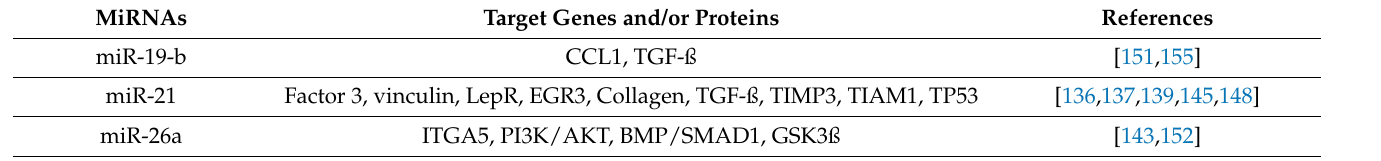
Table 7. This table summarizes the various miRNAs and their genes and/or proteins target, as studied in the papers included in this review, if available. CCL, chemokine ligand; TGF, transforming growth factor; LepR, leptin receptor; EGR, early growth response; TIMP, metallopeptidase inhibitor; TIAM1, T-cell lymphoma invasion and metastasis inducing protein 1; TP, tumor protein; ITGA, inte- grin subunit alpha; PI3K, phosphoinositide 3 kinase; AKT, protein kinase B; mTOR, mammalian target of rapamycin; BMP, bone morphogenetic protein; SMAD, small mother against decapentaplegic; GSK, glycogen synthase kinase; IGR1R, insulin-like growth factor 1 receptor; IL, interleukin, PTPRC, protein tyrosine phosphatase receptor type C; CD, differentiation cluster; SHIP2, SH2-containing phosphatidylinositol 3,4,5-trisphosphate 5-phosphatase; RNU6B, RNA U6 small nuclear; MAPK, mitogen-activated protein kinase; NF-kB, nuclear factor kappa-light-chain-enhancer of activated b cells; TCF-4, transcription factor 4; ID-2, inhibitor DNA-binding 2 protein HLH; VEGFA, vascular en- dothelial growth factor A; NRCAM, neuronal cell adhesion molecule; C-MET, tyrosine-protein kinase Met; LASP1, LIM and SH3 protein 1; RAN, RAs-related nuclear protein; RAPH1, Ras-associated and pleckstrin homology domains-containing protein 1; ERM, ezrin/radixin/moesin; DDK2, dickkopf- related protein 2; FRAT2, FRAT regulator of Wnt signaling pathway 2; MK2, mitogen-activated protein kinase-activated protein kinase 2; YAP1, yes-associated protein 1; MKI67, marker of prolifera- tion